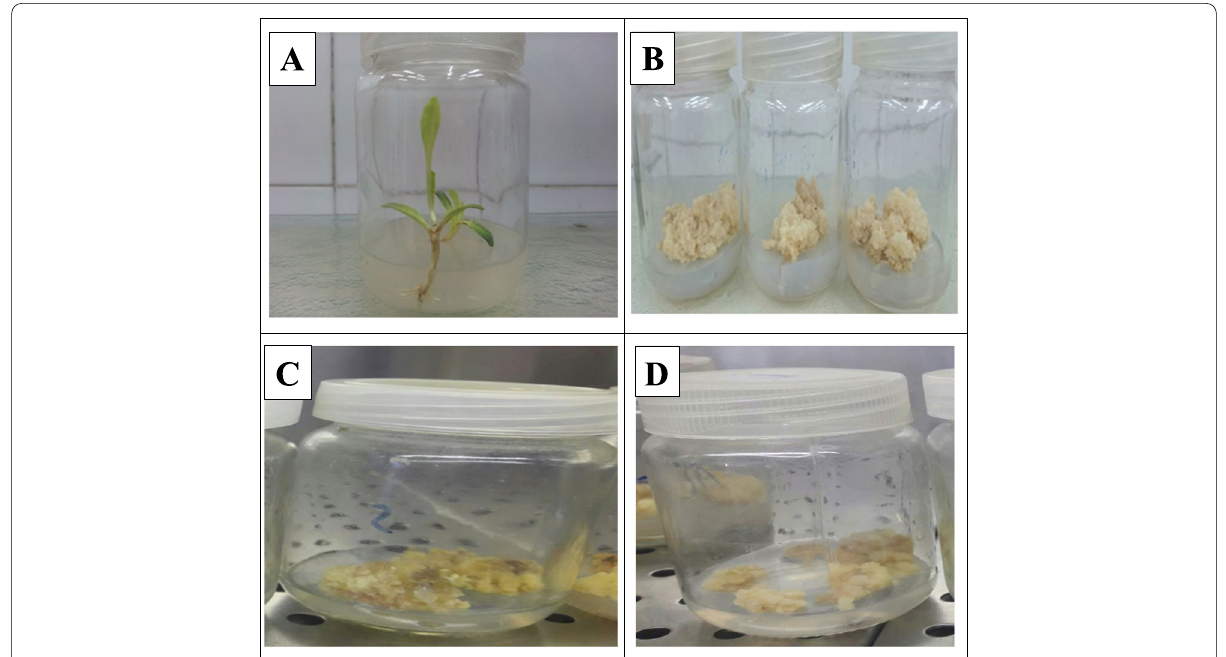
Fig. 1 Seed germination of S. marianum L. on half‑strength Murashige and Skoog (MS) medium ( A ), calli formation from stem segments on MS medium supplemented with 1 mg/l 2,4‑D and 0.5 mg/l BA ( B ), and calli from stem explants derived from seeds exposed to 25 Gy ( C ) or 50 Gy ( D )